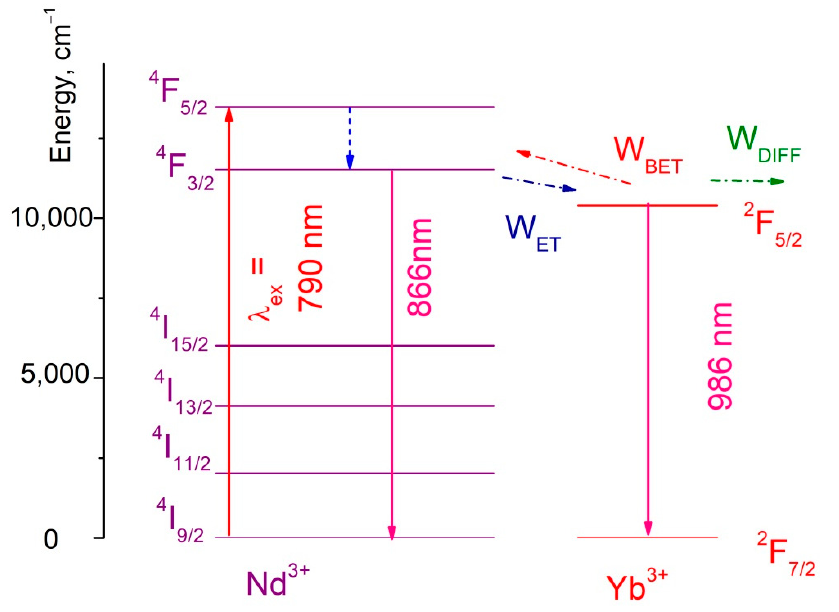
Figure 3. An energy level diagram of the Nd 3+ /Yb 3+ ion pair. Here W ET —probability of energy transfer from Nd 3+ to Yb 3+ , W BET —probability of back energy transfer from Yb 3+ to Nd 3+ , W DIFF —probability of energy diffusion between Yb 3+ ions.